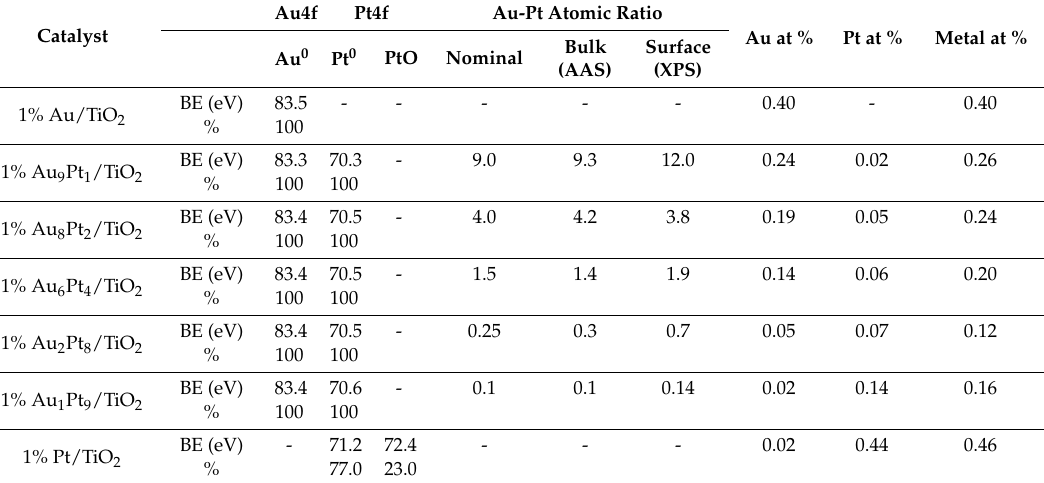
Table 1. Binding energy of Au4f 7/2 and Pt4f 7/2 , % abundance of Au and Pt species metal exposure (at